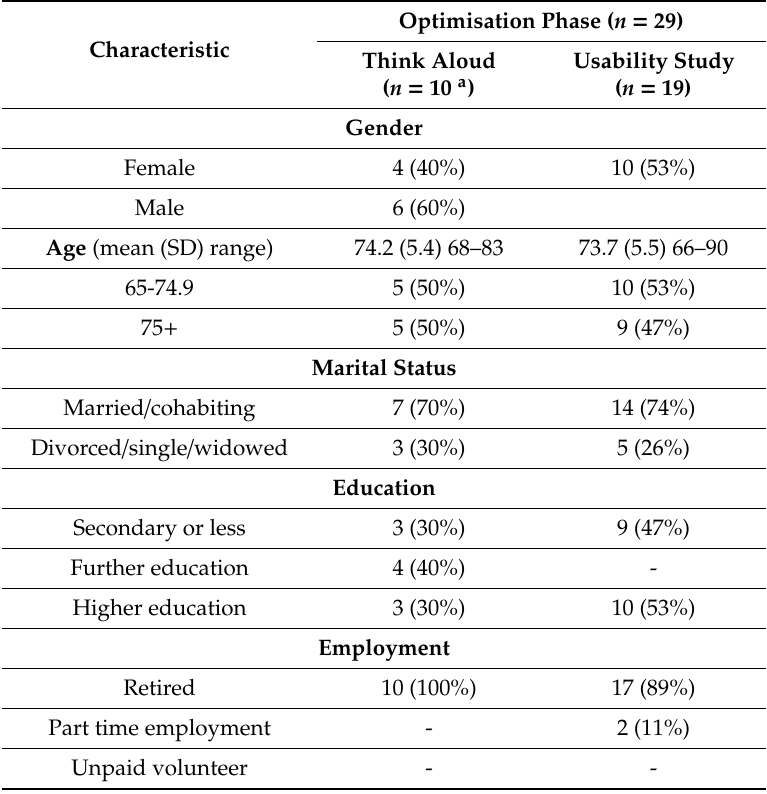
Table 4. Characteristics of participants in the optimisation